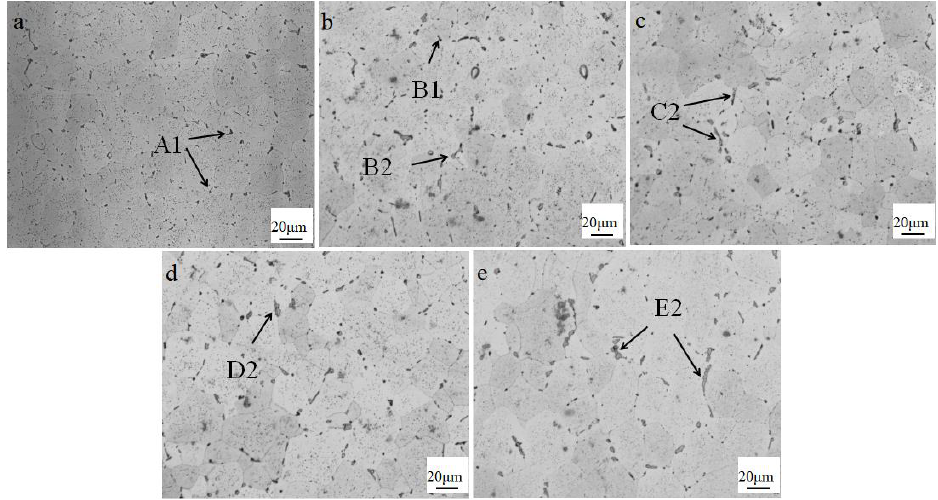
Figure 6. Microstructure of deposits with different heat input in T6 state. ( a ) 30 J/mm; ( b ) 60 J/mm; ( c ) 90 J/mm; ( d ) 120 J/mm; ( e ) 150 J/mm.